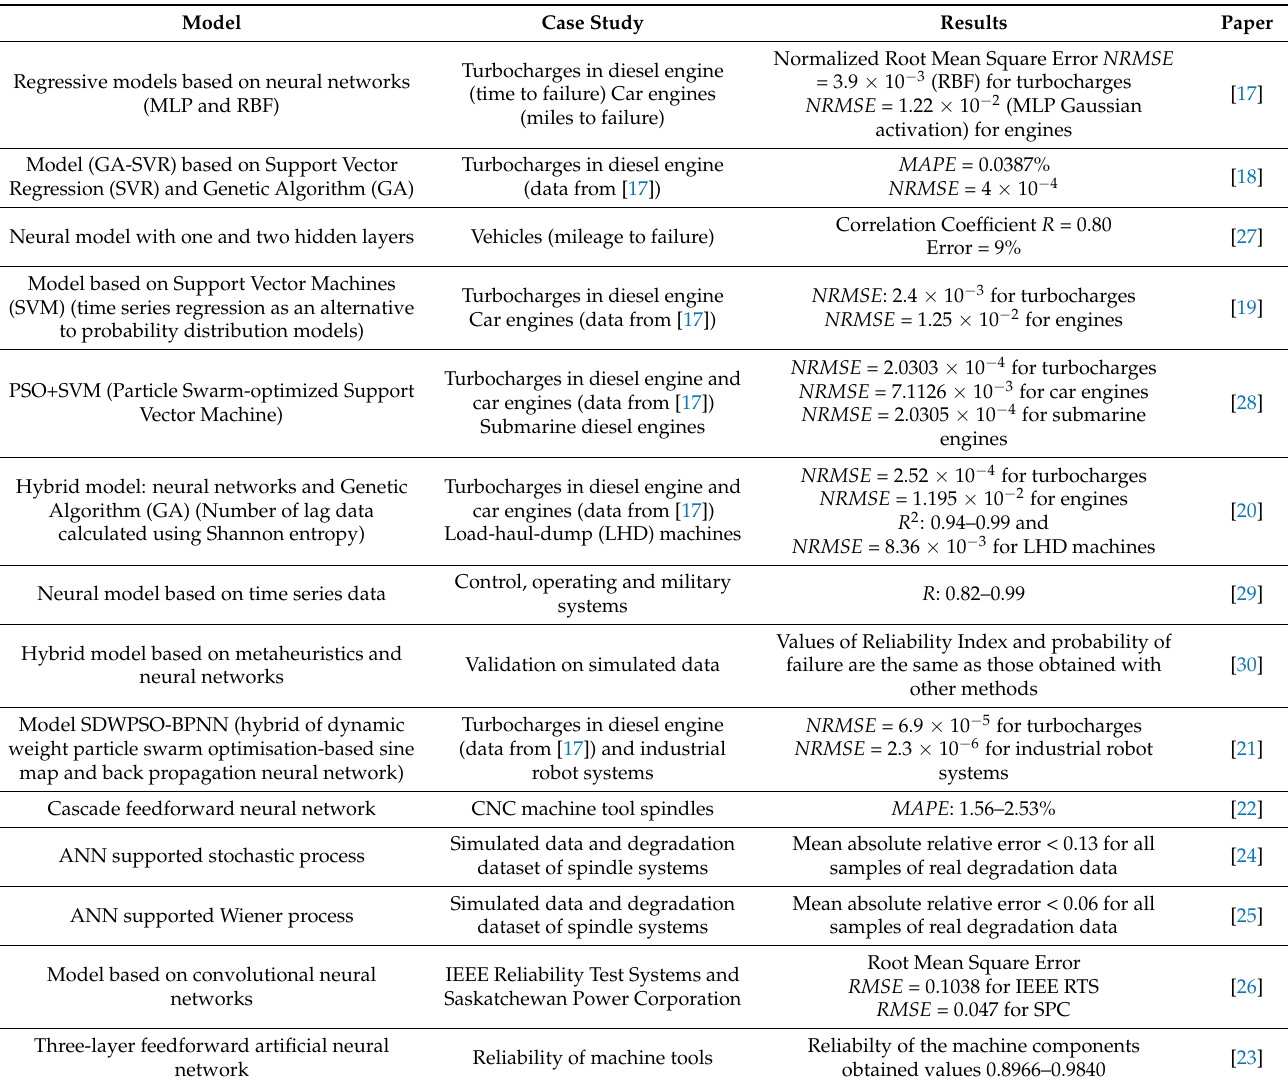
Table 1. Neural modelling of reliability—literature